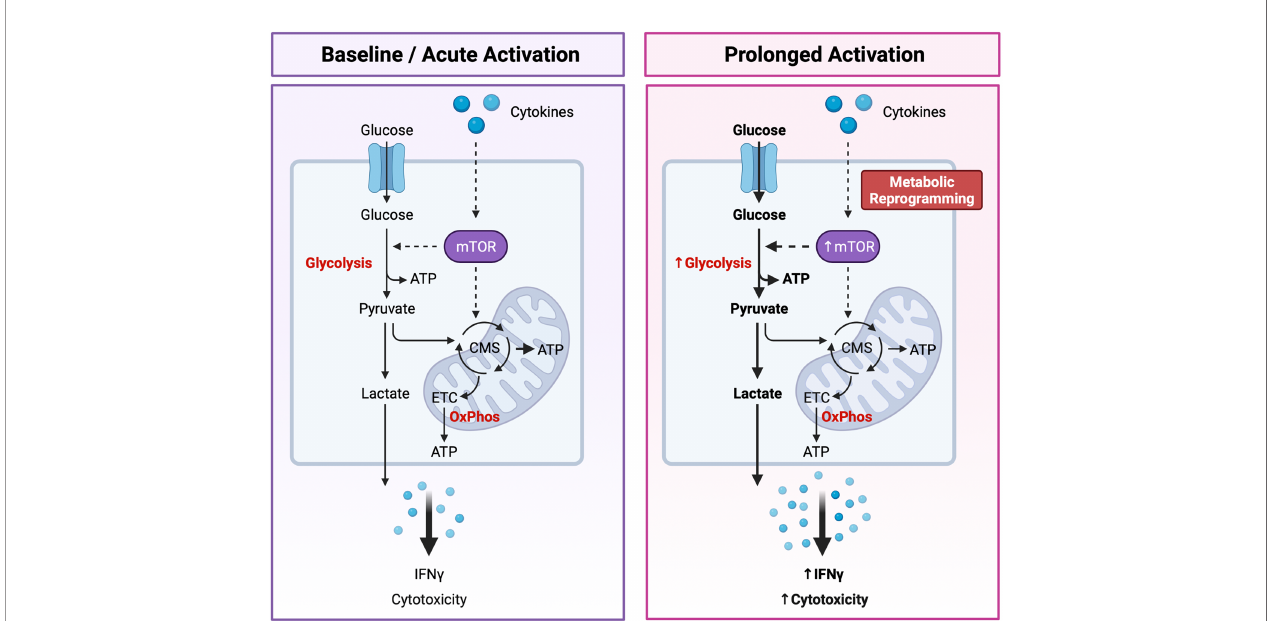
FIGURE 3 | Dynamic Changes in Glucose Metabolism Underly NK Cell Effector Potential. NK cells are primarily fueled by glucose. Following uptake into the cytoplasm, glucose is fi rst converted to pyruvate through glycolysis, generating two molecules of adenosine triphosphate (ATP) per glucose molecule. Pyruvate is then either converted to lactate and expelled from the cell or transported to the mitochondria where it is further metabolized through the citrate malate shuttle (CMS) to fuel the electron transport chain (ETC) and oxidative phosphorylation (OxPhos), driving ef fi cient production of ATP. Basal rates of glycolysis and OxPhos are suf fi cient to fuel the homeostatic needs and acute effector functions of resting NK cells. Following prolonged cytokine stimulation NK cells experience an increase in the rates of glycolysis and OxPhos to support their increased capacity for IFN g production and cytotoxic activity. Highly cytotoxic NK cells can also undergo cytokine-induced metabolic reprogramming towards glycolysis through the mechanistic target of rapamycin (mTOR), a master regulator of cellular metabolism. An increased capacity for glucose-driven metabolism and more robust activation of the mTOR pathway identi fi es NK cells with the greatest cytotoxic potential. Created with